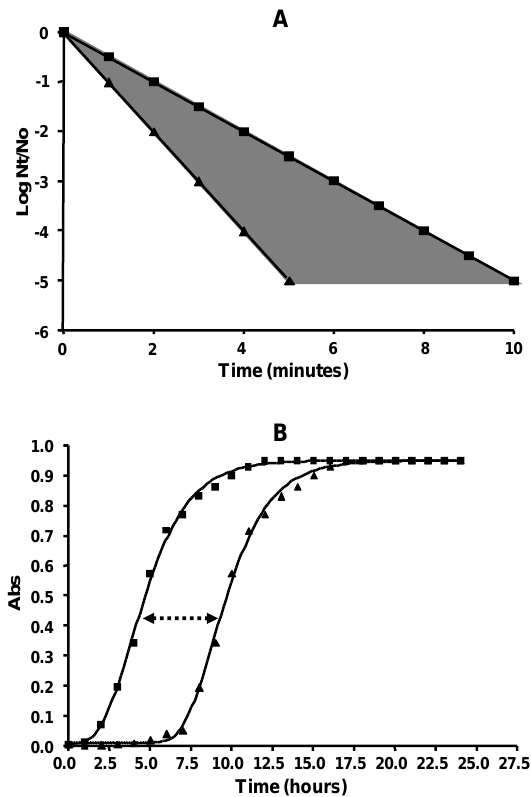
Figure 3. Commonly used experimental approaches to study sublethal heat injury. ( A ) Differential plating technique in non-selective ( ■ ) and selective medium ( ▲ ): the shadowed area corresponds to the population with sublethal injuries. ( B ) Study of the growth dynamics of non-injured ( ■ ) and injured populations ( ▲ ) after heat treatment: the lag phase is longer in the latter. N t : number of microorganisms at time t. N 0 : number of microorganisms at time 0. Abs: absorbance. The addition of inhibitory compounds to the recovery medium has been used to detect particular cellular alterations in heat-treated cells. For example, it is assumed that the addition of NaCl inhibits the growth of cells with damages in their cytoplasmic membrane, thus unable to control the passage of ions in and out of the cell. Cells with an intact membrane are able to grow in both media, whereas cells with a damaged membrane only grow in the medium without NaCl.